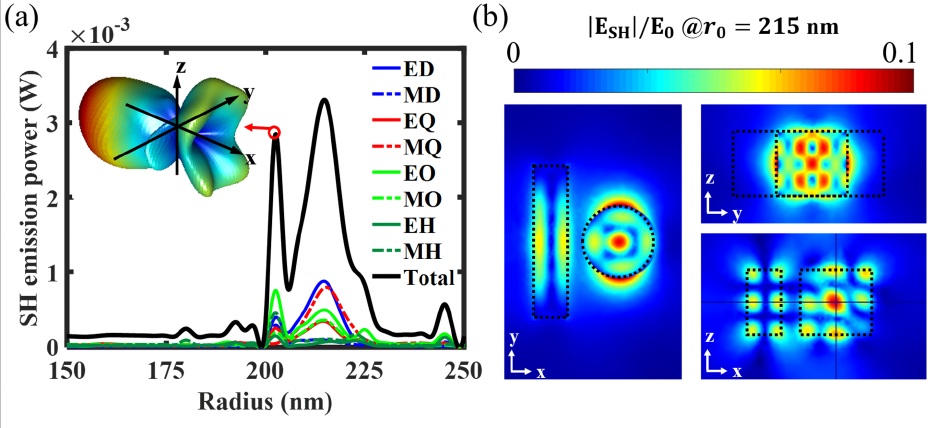
Figure 7. ( a ) Calculated SH emission power and the nonlinear multipolar structure with different disk radii. The inset shows the corresponding SH far-field pattern for disk radius r 0 = 202.5 nm. ( b ) Near-field distributions of the SH electric field magnitude for disk radius r 0 = 215 nm. θ c =